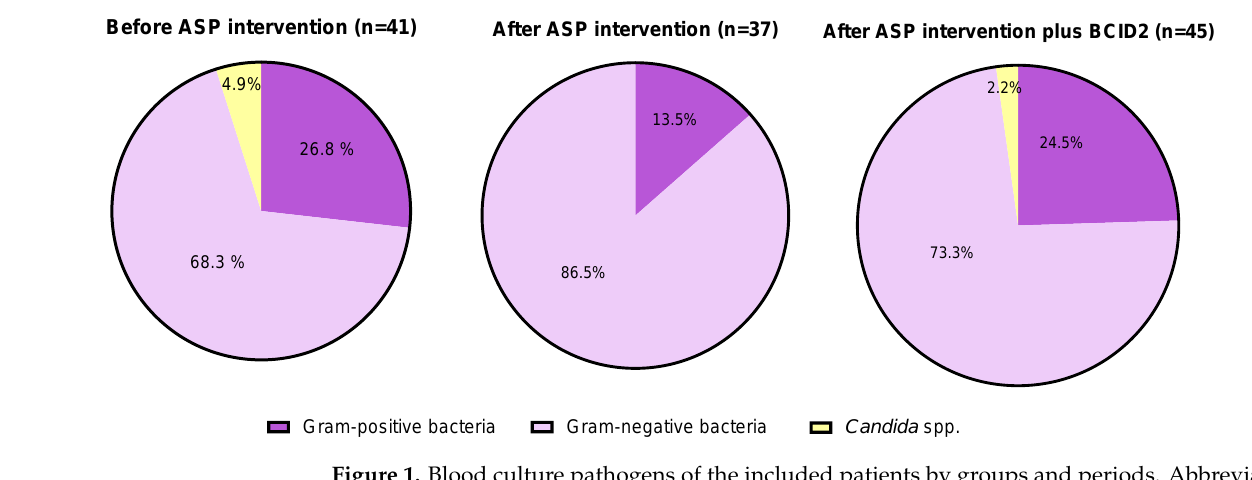
Figure 1. Blood culture pathogens of the included patients by groups and periods. Abbreviations: Table 2. A description of blood culture pathogens and microbiology-related